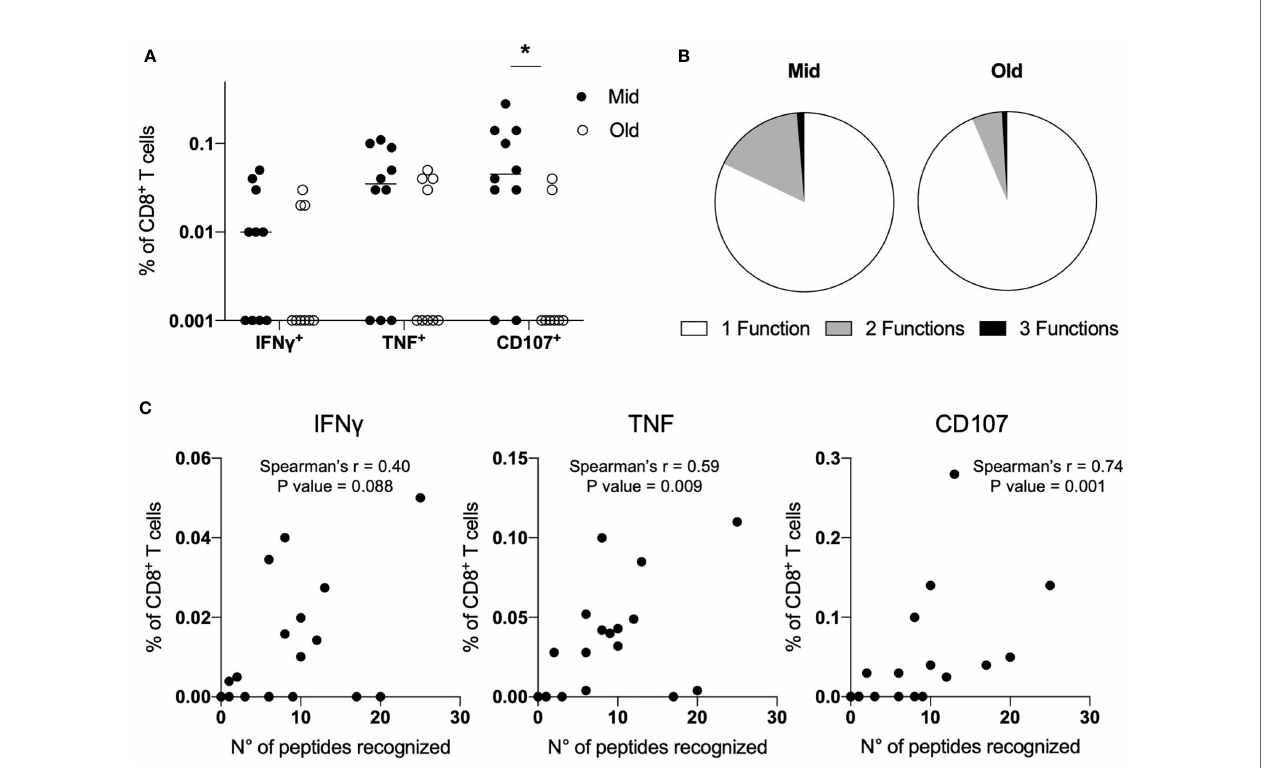
FIGURE 3 | Altered functions of primed SARS-CoV-2-speci fi c CD8 + T cells in older subjects. (A – C) PBMCs (7 × 10 7 ) were primed in vitro with a pool of 37 SARS- CoV-2-derived peptides. After ten days, the frequency of epitope-speci fi c primed naive CD8 + T cells was measured; upon restimulation with the same peptide pool, the expression of IFN g , TNF, and CD107 was assessed by ICS. Data are shown as percentage of CD8 + T cells after background (NT) subtraction, and lines represent median values (A) . Polyfunctional capacity was determined and shown as a mean for Mid and Old donors (B) . The number of recognized peptides determined by IFN g ELISpot was correlated with the production of IFN g or TNF and the expression of CD107 determined by ICS (C) . Statistical signi fi cance was determined by Mann – Whitney test (A) and Spearman ’ s rank correlation (C) , *p <